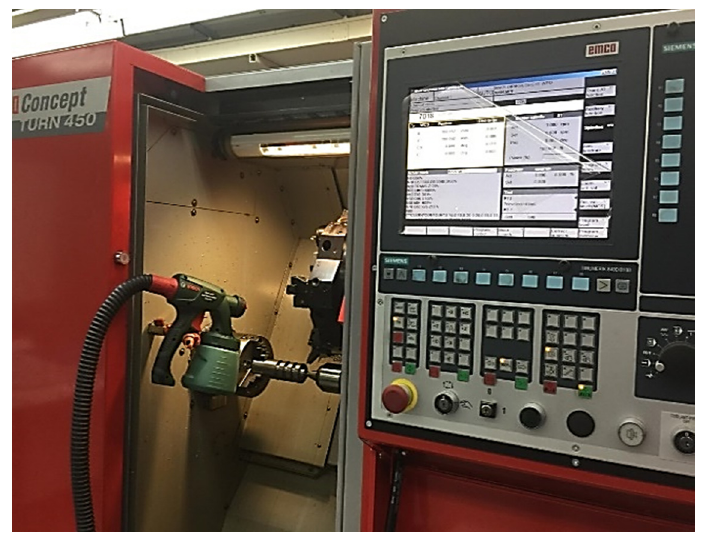
Figure 3. The experimental setup view.